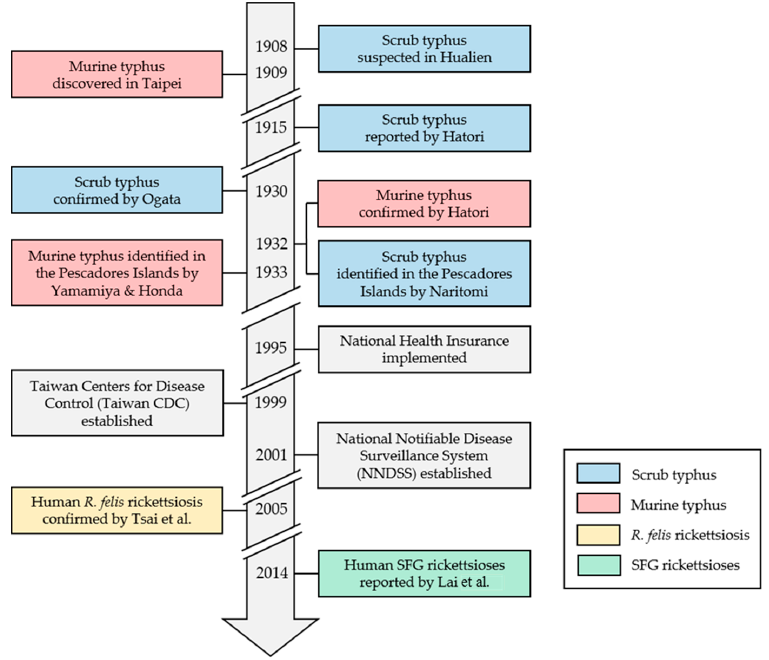
Figure 1. Historical review of human vector-borne rickettsioses (VBR) and recent public